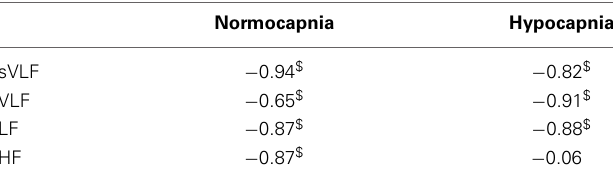
Table 2 | Correlation (Pearson correlation coefficients) between phase and gain within different frequency ranges with respect to normo- and